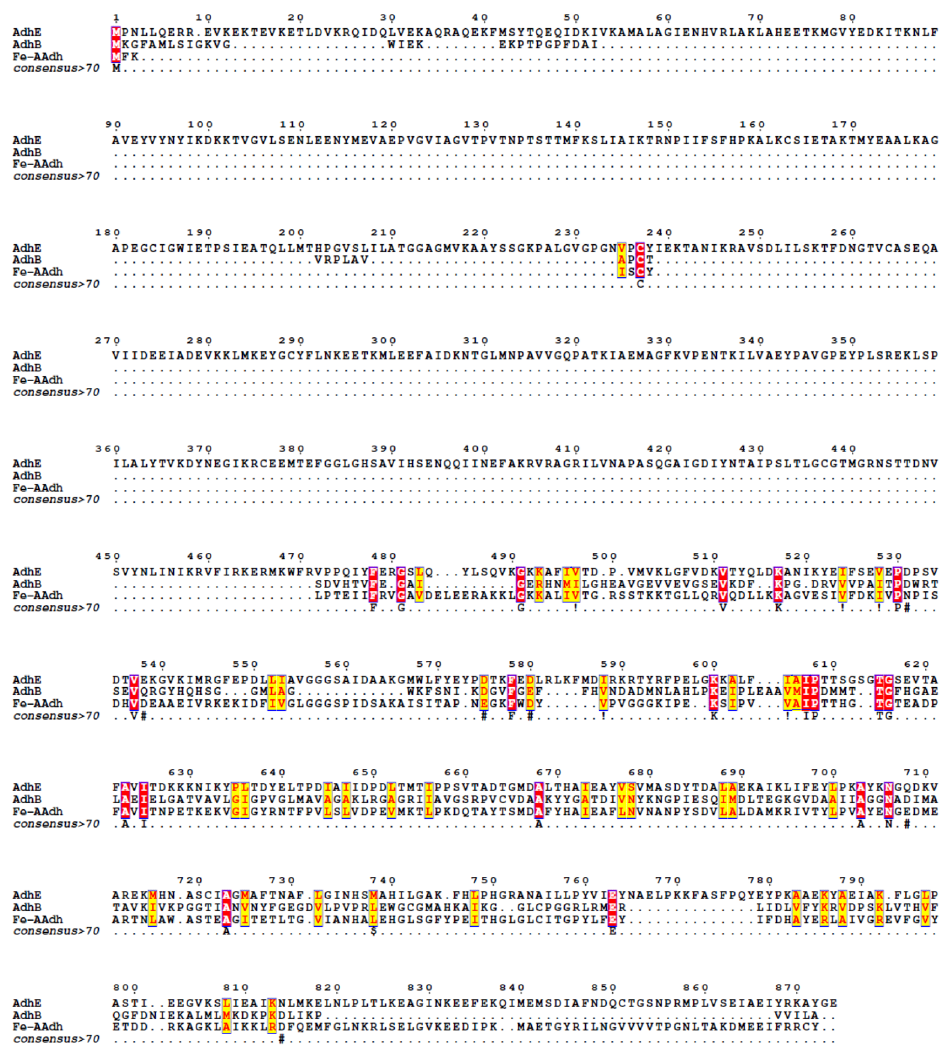
Figure 4. The multi-sequence alignment of bifunctional aldehyde/alcohol dehydrogenases. The domain from residue 30 to 412 of AdhE is related to the aldehyde dehydrogenase family (ALDH-SF superfamily), the domain from residue 551 to 854 belongs to Fe-alcohol dehydrogenase family (PF00465).